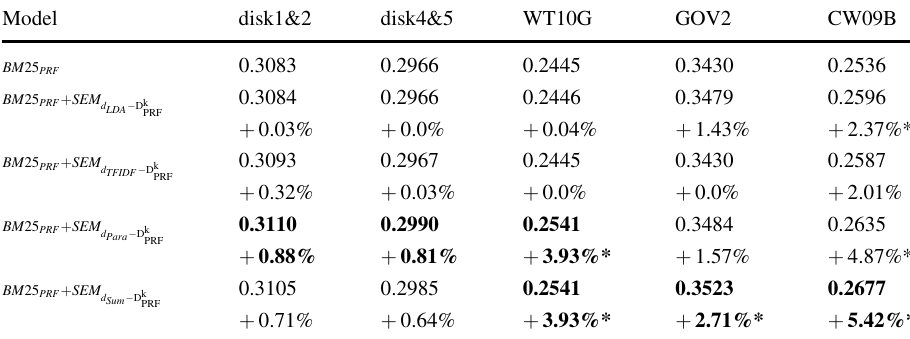
Table 12 Comparison to BM25 with Rocchio’s PRF ( BM 25